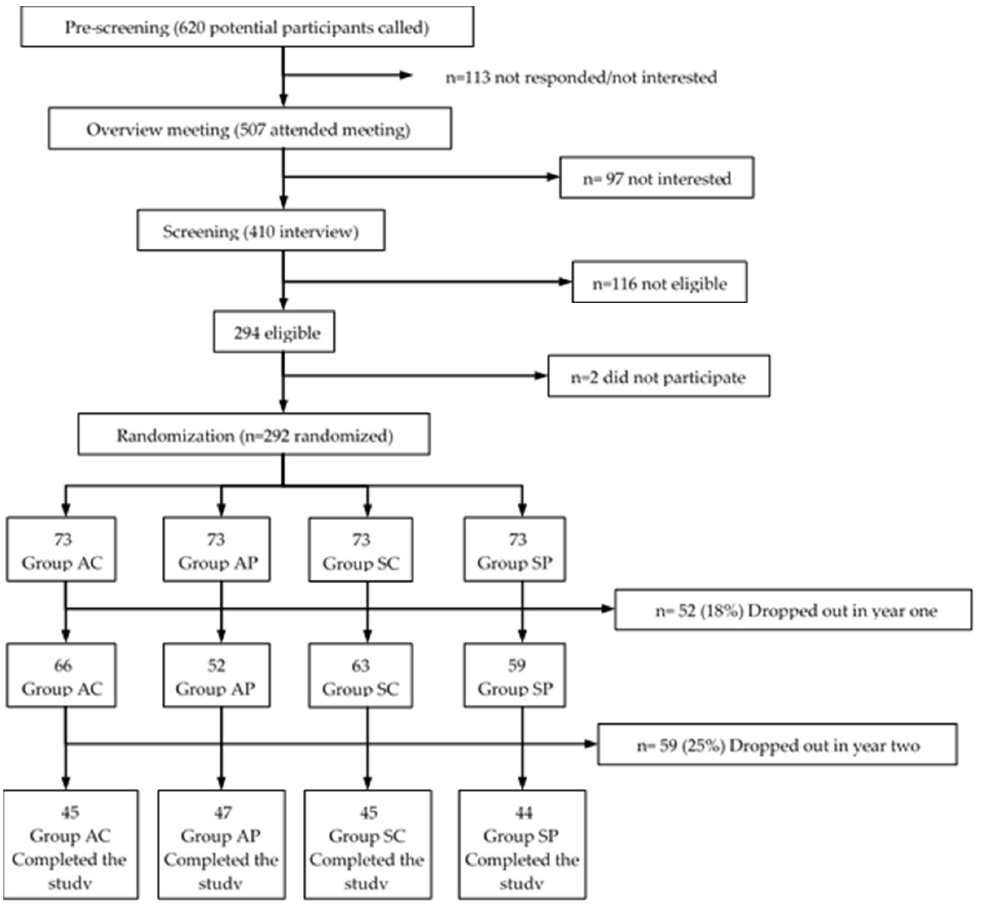
Figure 1. Sequence for recruitment screening. AC: active/clean air group; AP: active/polluted air group; SC: sedentary/clean air group; SP: sedentary/polluted air group.